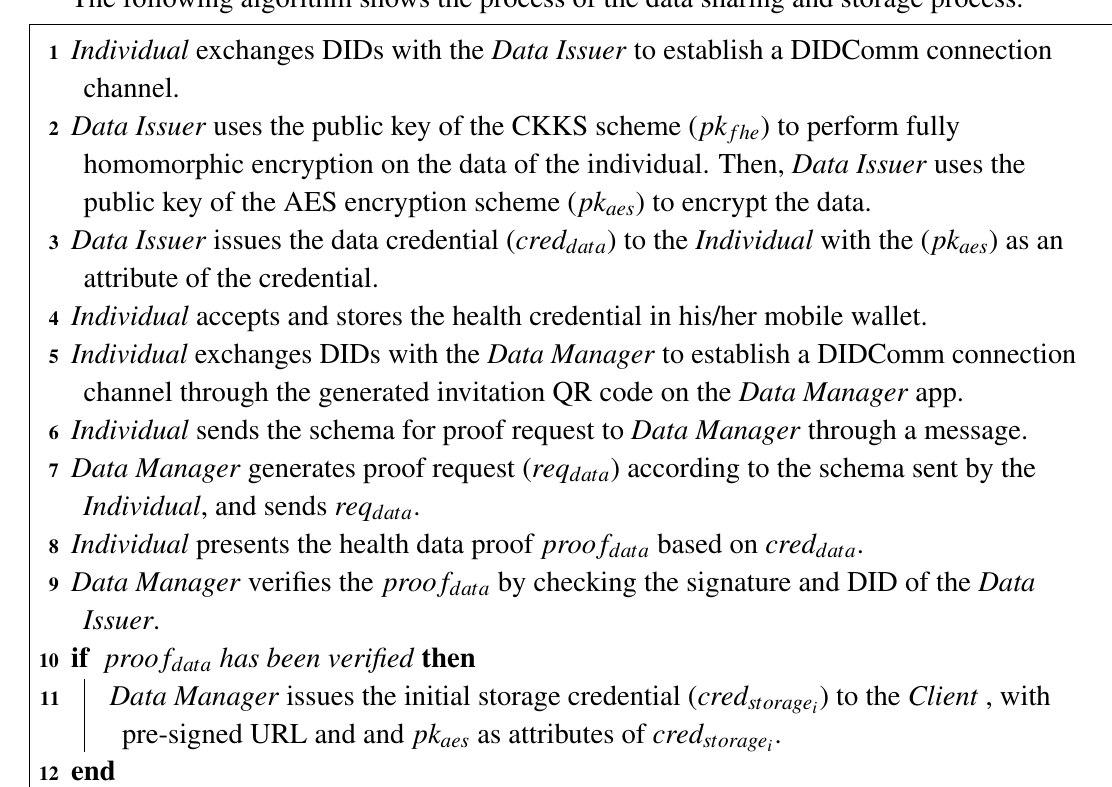
Algorithm 2: Data Sharing and Storage